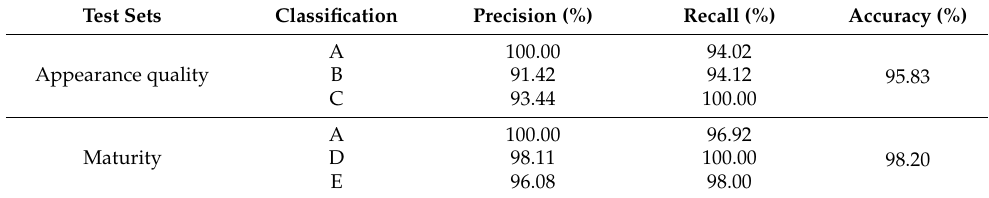
Table 3. Maturity and appearance quality test results.